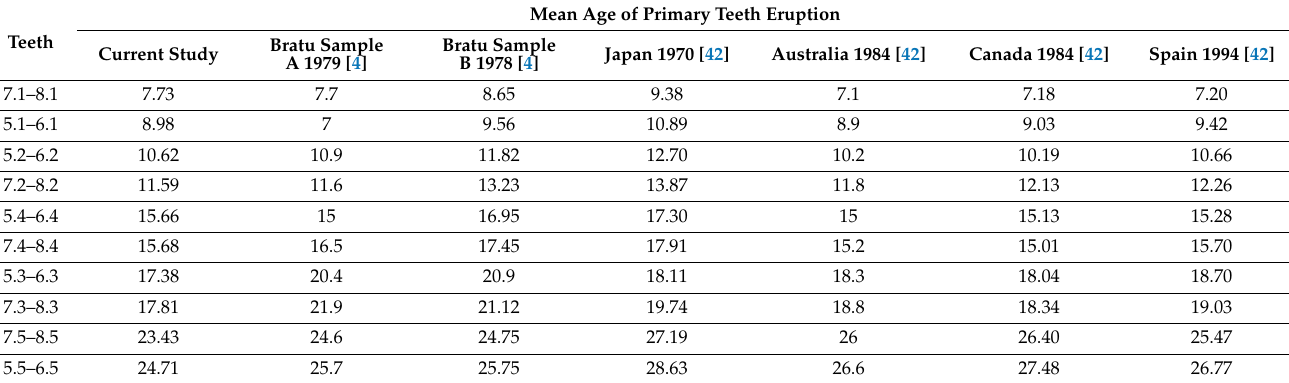
Table 7. Comparison of the average values obtained with average values from other studies [4,42]. Mean Age of Primary Teeth Teeth